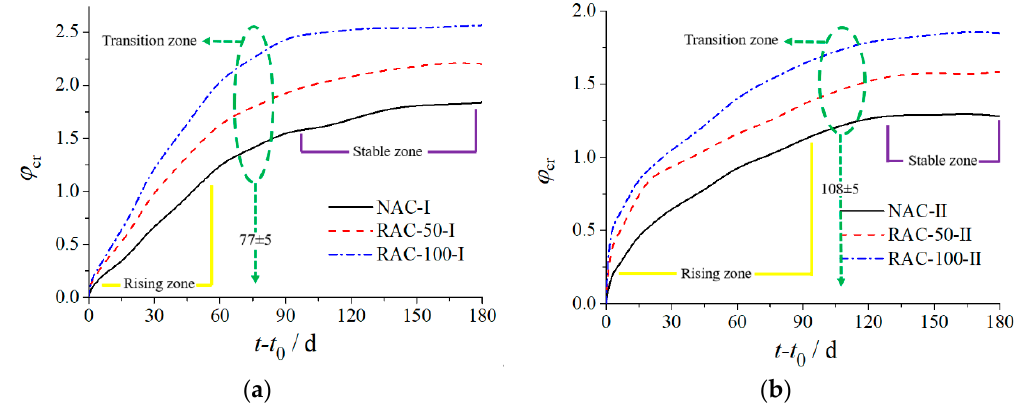
Figure 3. Creep coefficient curve of RAC. ( a ) w/c = 0.527; ( b ) w/c = 0.4. Note: ε (cid:2929)(cid:2918) indicates shrinkage Figure 3. Creep coe ffi cient curve of RAC. ( a ) w / c = 0.527; ( b ) w / c = 0.4. Note: ε sh indicates shrinkage strain and is dimensionless; k(cid:3364) indicates the slope and is dimensionless; t (cid:2868) indicates the loading age strain and is dimensionless; k indicates the slope and is dimensionless; t 0 indicates the loading age of of concrete; t indicates the age of the concrete. concrete; t indicates the age of the